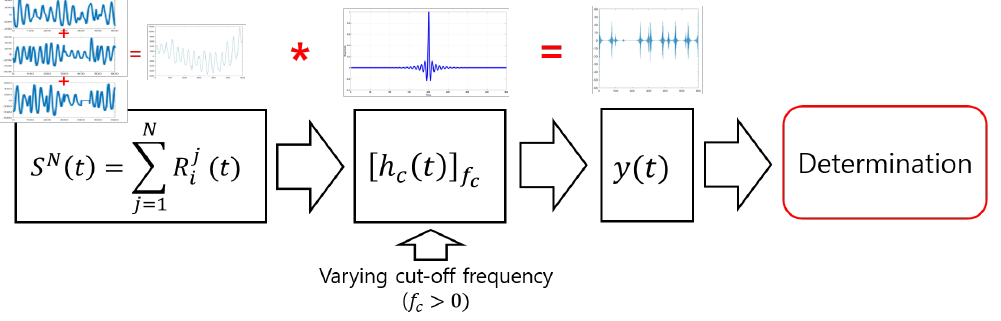
Figure 5. Overall work flow for detecting existence of abnormal respiration with multiple